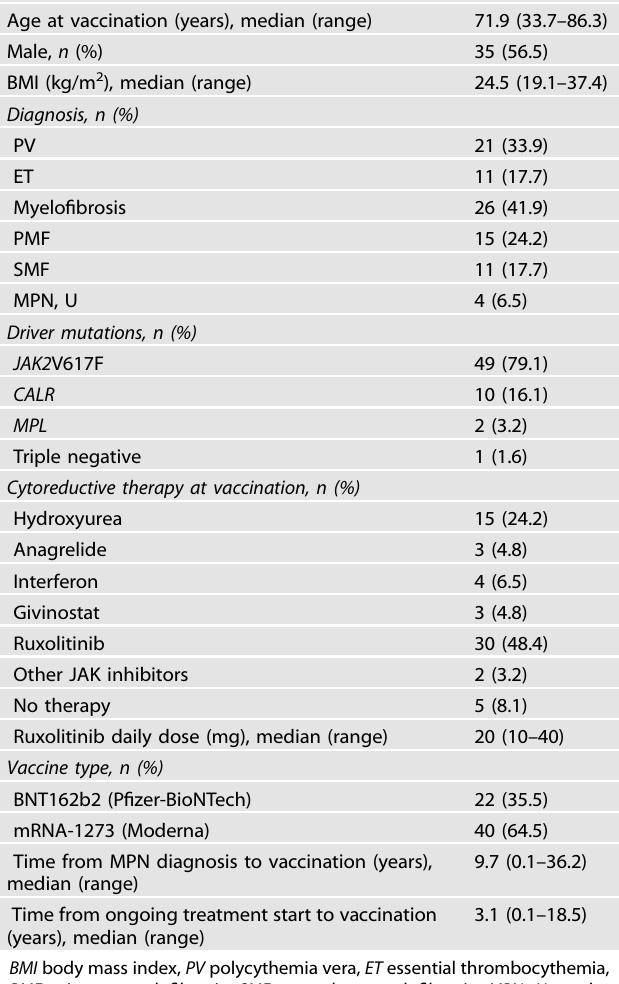
Table 2. Predictors of response to vaccine in BCR-ABL1 -negative MPN patients. Patients ( N . 62) Variable